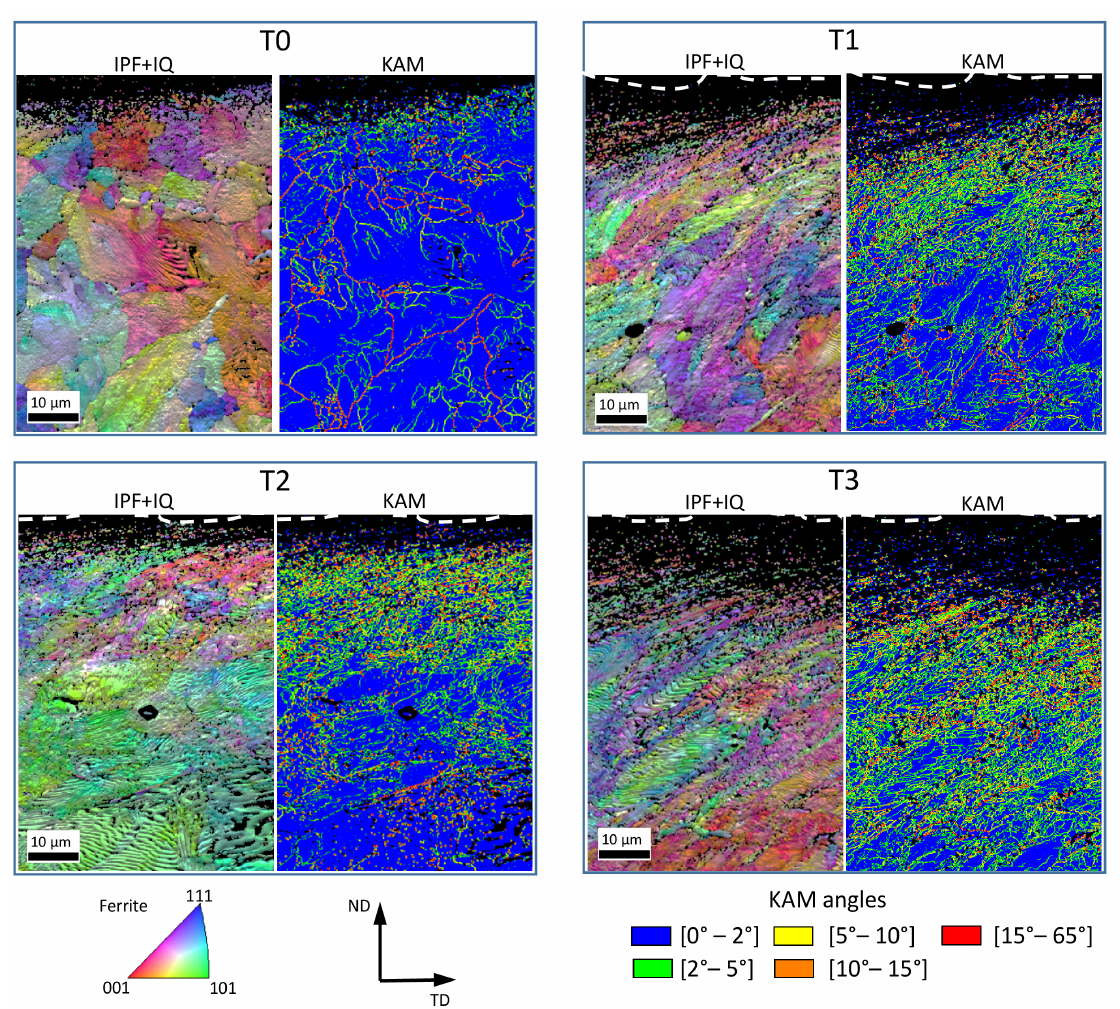
Figure 10. IPF map with IQ and KAM maps for the non-deformed state (T0) and the different testing conditions (T1, T2, T3), for Ring AT-C. The measurements were performed along the transverse direction.